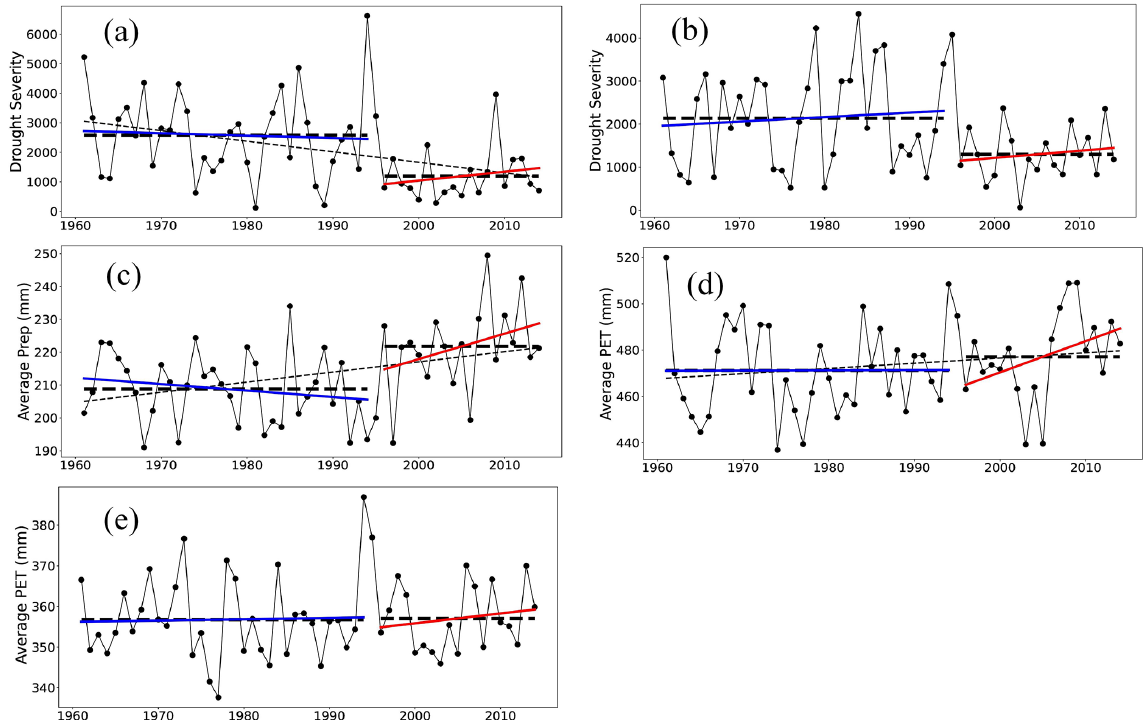
Figure 9. Variations of the total annual SM drought severity for (a) GLDAS and (b) ERA5, (c) yearly average precipitation (Prep) of CMA, and potential evapotranspiration (PET) of (d) GLDAS and (e) ERA5 over the summer period (May–September) from 1961 to 2014. The dotted black lines are the average values over periods before and after the middle to late 1990s. The blue and red lines indicate the tendency for periods before and after the middle to late 1990s,